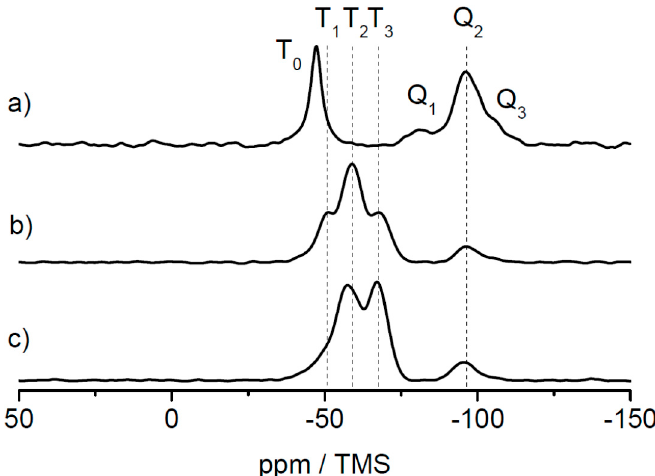
Figure 9. 29 Si CP MAS spectra of samples based on the MPSEt linker system in three different states: ( a ) lyophilized powder, ( b ) hybrid film, and ( c ) hybrid film after heat treatment, and signal assignment of T n groups ( n = 0, 1, 2, 3) and Q n groups ( n = 1, 2, 3). Spectra were measured at 14 T at a spinning rate of 8 kHz.